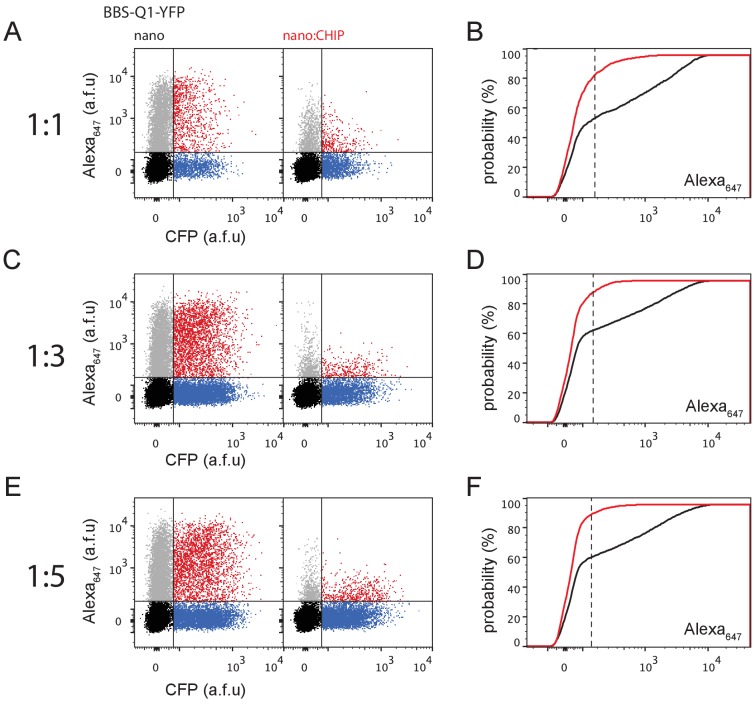
Titration of nanoCHIP expression.(A,C,E) Flow cytometry analyses of surface Q1 channels (Alexa647 fluorescence) in cells expressing BBS-Q1-YFP + nanobody (left, control) or BBS-Q1-YFP + nanoCHIP (right), using 1:1 (A), 1:3 (C), and 1:5 (E) transfection ratios of BBS-Q1-YFP:nanoCHIP plasmids. (B,D,F) Cumulative distribution histograms of Alexa647 fluorescence for BBS-Q1-YFP co-expressed with either nanobody (black line) or nanoCHIP (red line).